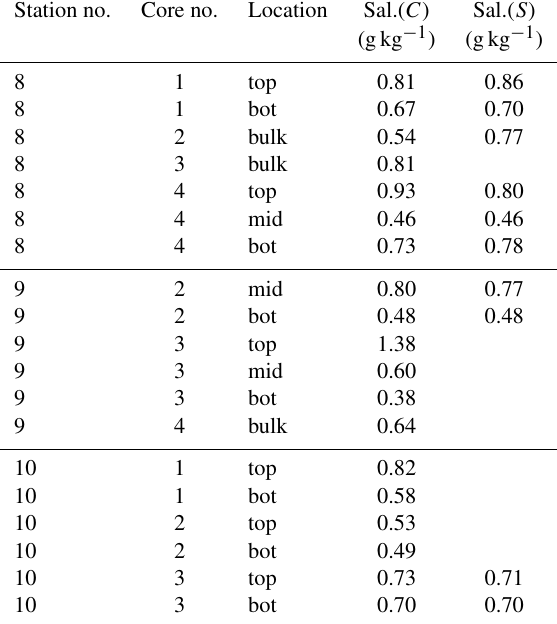
Table 1. Ice core samples from stations 8, 9, and 10. Location shows which part of the core is used for analysis. Top, mid, and bot are the upper, middle, and lower parts of the ice core, respectively. Bulk is for the whole ice core. Sal.( C ) and Sal.( S ) are the absolute salinity measured with mini CTD and salinometer, respectively. Station no. Core no. Location